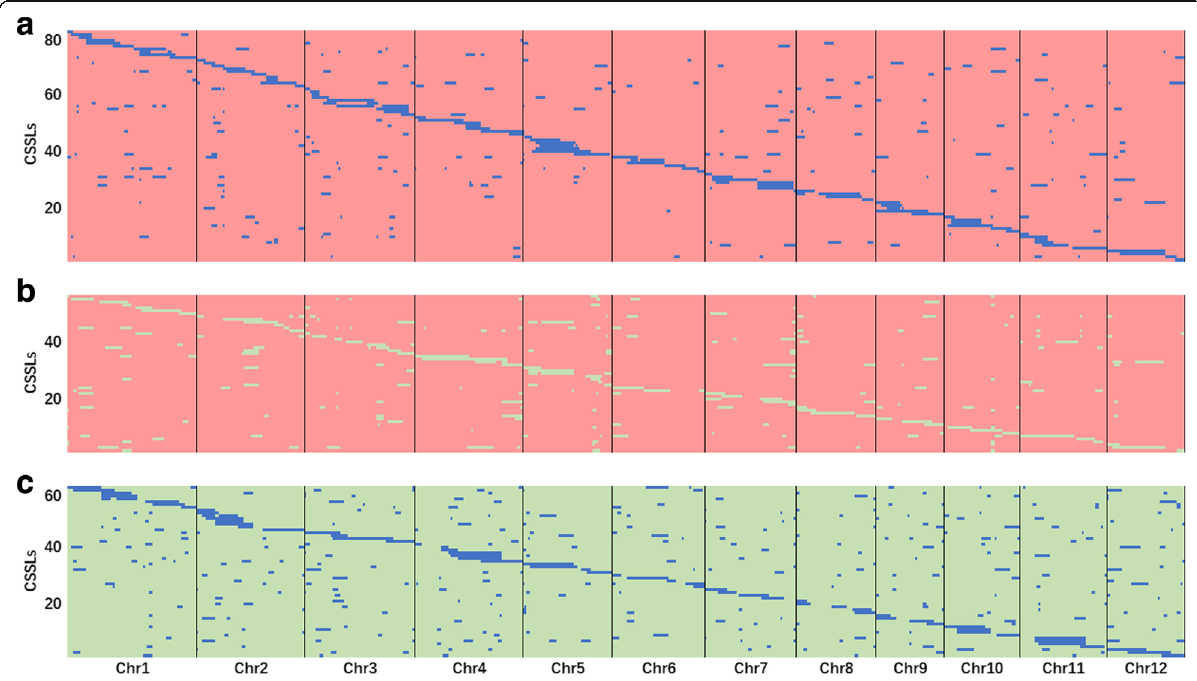
Fig. 2 Graphic genotypes of 3 sets of CSSLs. a Genotypes of A set CSSLs. b Genotypes of B set CSSLs. c Genotypes of C set CSSLs. Different colors represent different genotypes: red, 9311; blue, PA64s; green, Nipponbare. Each row represents a CSSL. Chr is short for chromosome